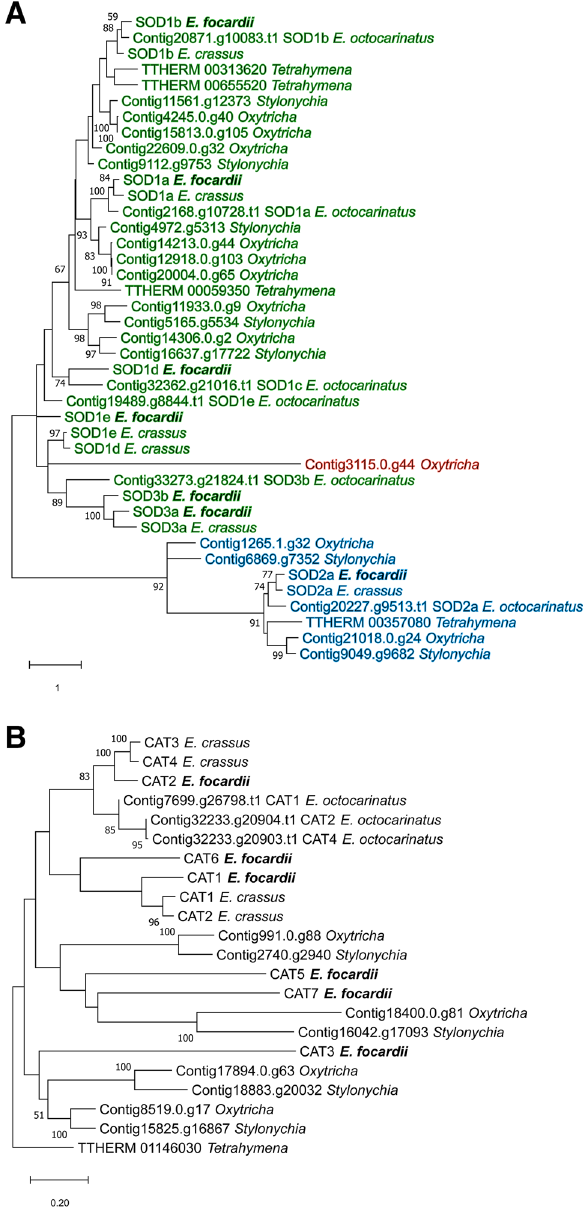
Figure 4. Phylogenetic trees of SODs ( A ) and CATs ( B ). Only bootstrap percentage values higher than 50%, indicated near nodes, are shown. Copper/zinc SODs are highlighted in green, iron/manganese SODs in blue, and nickel SODs in